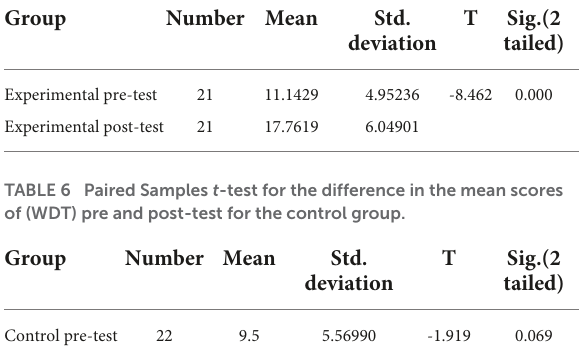
TABLE 5 Paired Samples t -test for the difference in the mean scores of (WDT) pre and post-test for the experimental group. Group